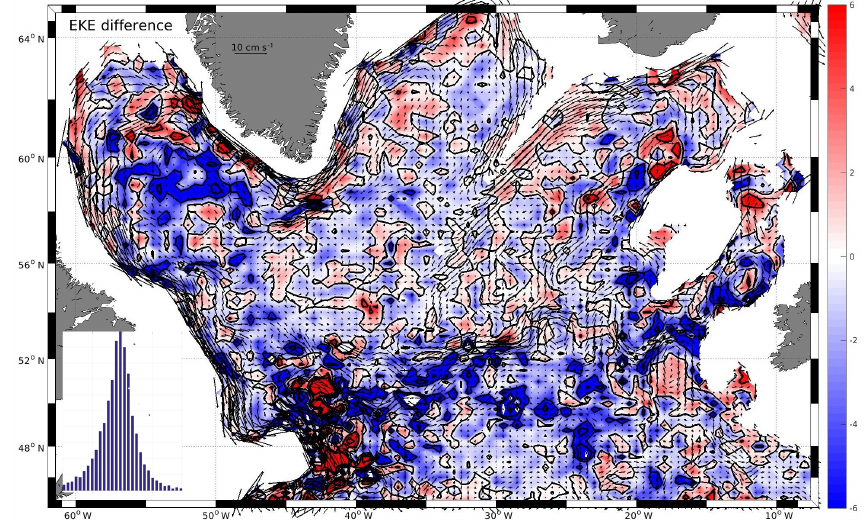
Figure 6. EKE map difference between optimum interpolation (OI) and Gaussian interpolation methods. Inset at lower left: histogram of difference reveals Gaussian shape and a weak bias of < dEKE > = − 1cm 2 s − 2